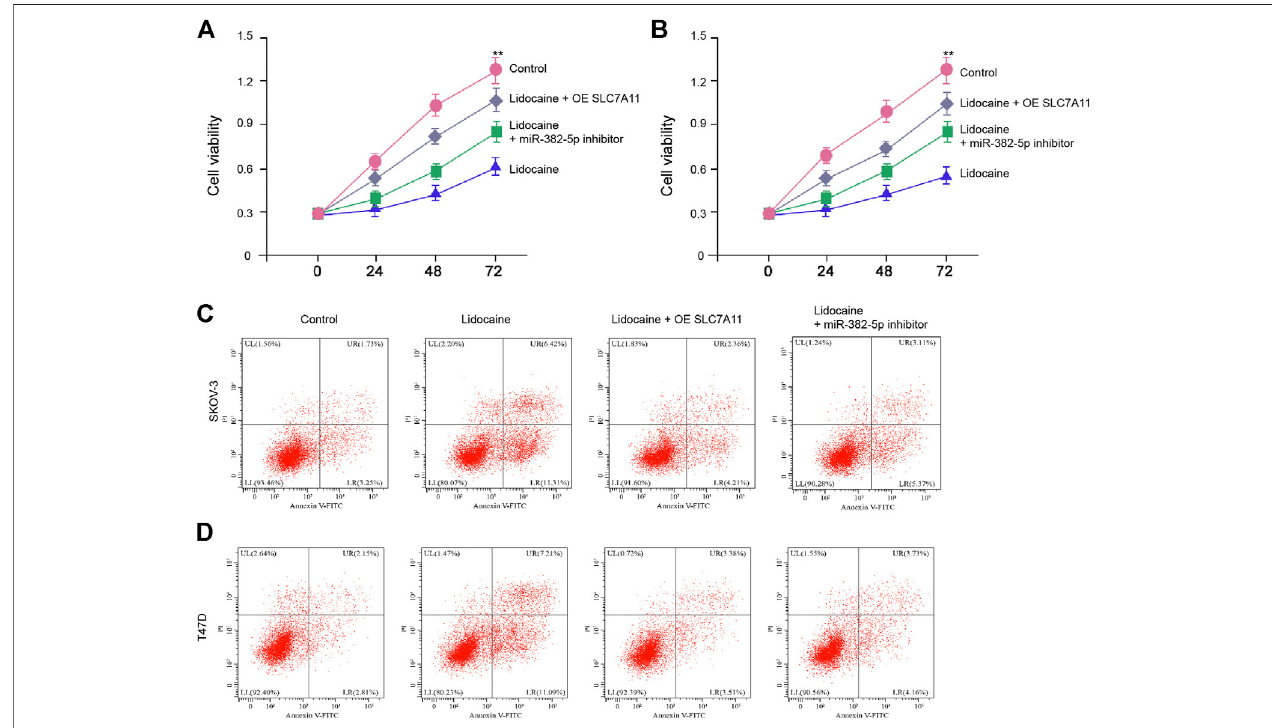
FIGURE 6 | Lidocaine/miR-382-5p axis reduces the proliferation of ovarian and breast cancer cells by targeting SLC7A11 in vitro . (A – D) SKOV-3 and T47D cells were co-treated with lidocaine (3 mM) and miR-382-5p inhibitor or SLC7A11 reconstitution vectors. (A,B) The cell viability was detected by MTT assays. (C,D) The apoptosis was analyzed by fl ow cytometry. mean ± SD, ** p < 0.01. The experiments were performed independently three times.